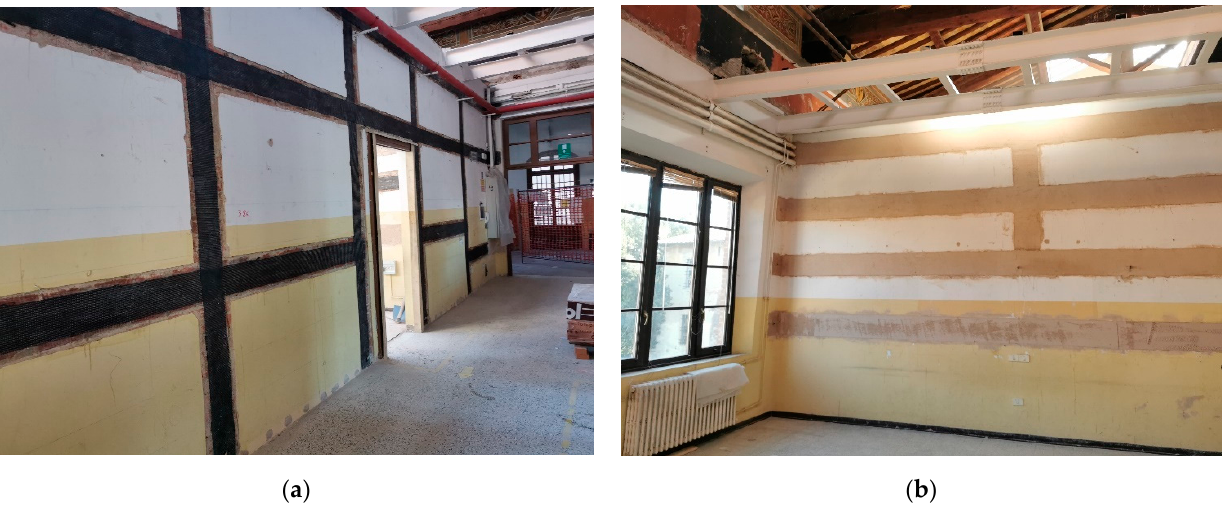
Figure 6. Composite intervention to avoid overturning of partition walls: ( a ) application of the composite reinforcement; ( b ) detail of the completed intervention.